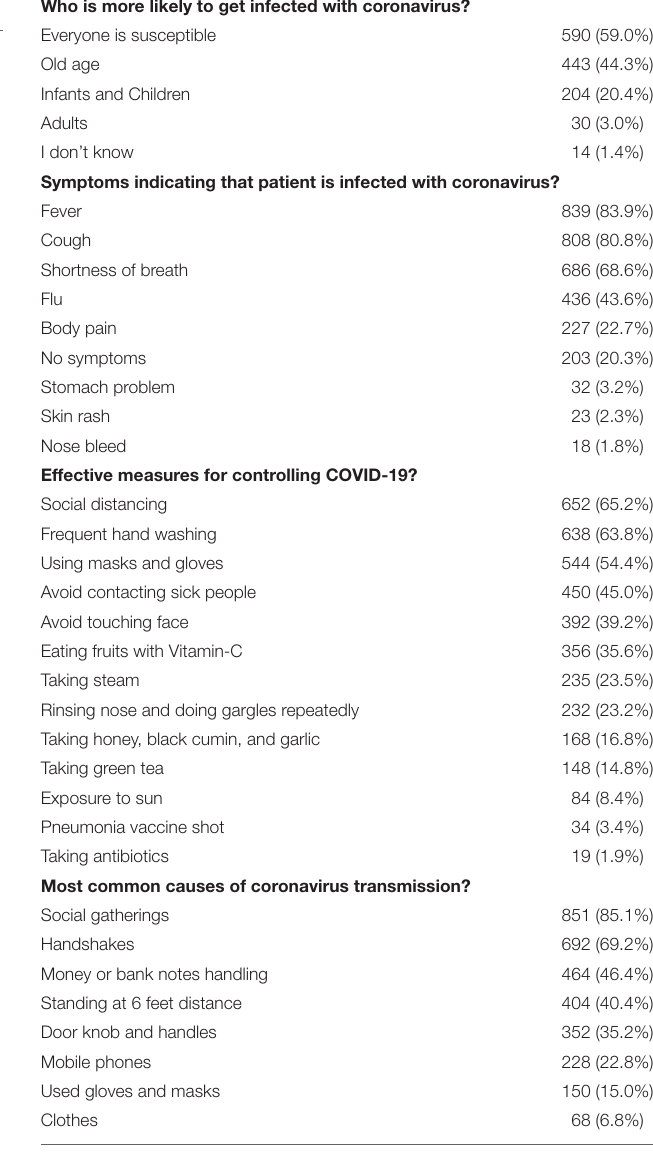
TABLE 1 | Attitudes, behavior and perceptions about COVID-19. TABLE 2 | Knowledge of COVID-19 among participants ( n =